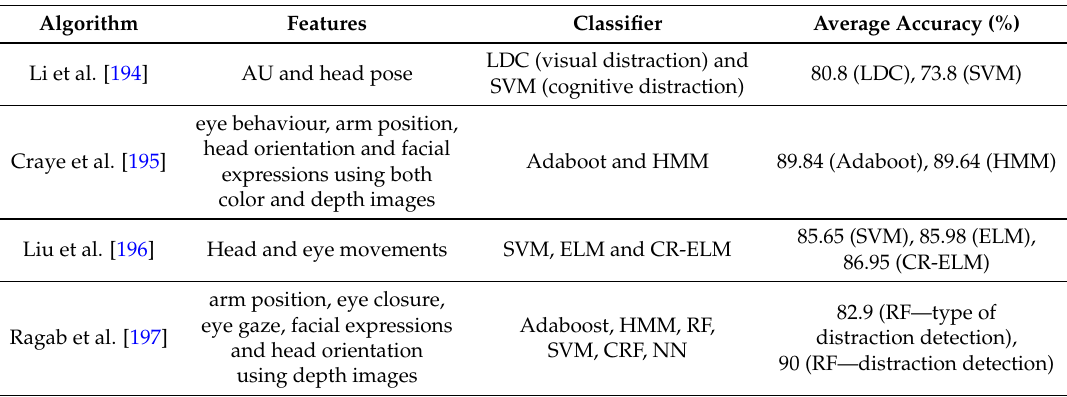
Table 7. Mixing types of distraction detection